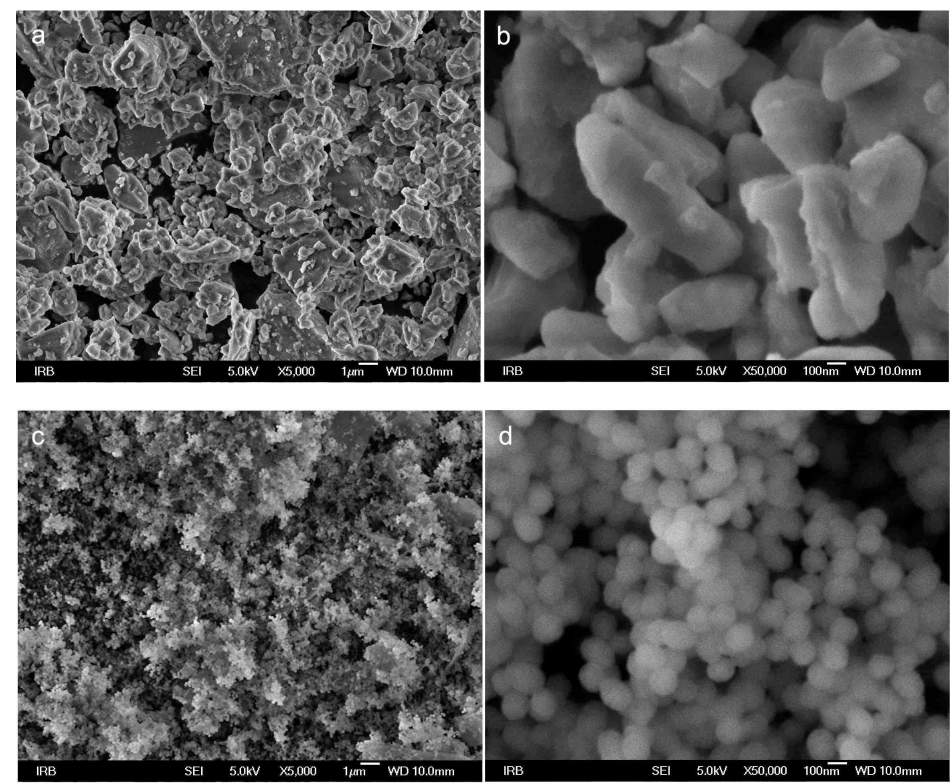
Figure 2. SEM of individual filler particles at 5000 × and 50,000 × magnification: ( a , b ) 45S5 bioactive glass; ( c , d )